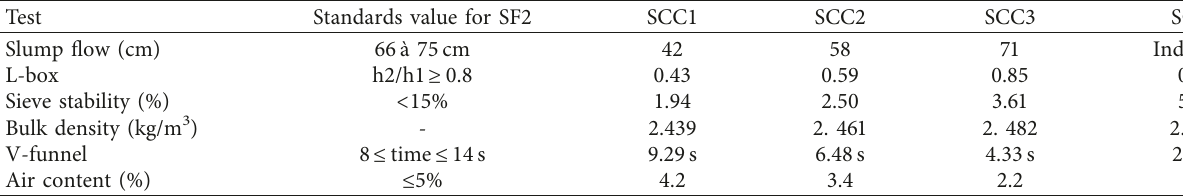
Table 7: Properties of the four SCCs in fresh state.